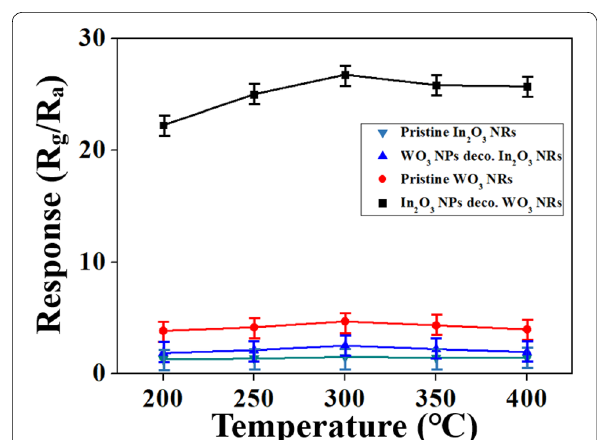
Fig. 4 Responses of In 2 O 3 NPs‑decorated WO 3 NRs and WO 3 NPs‑decorated In 2 O 3 NPs along with pristine WO 3 NRs and pristine WO 3 NRs at various operating temperatures to NO